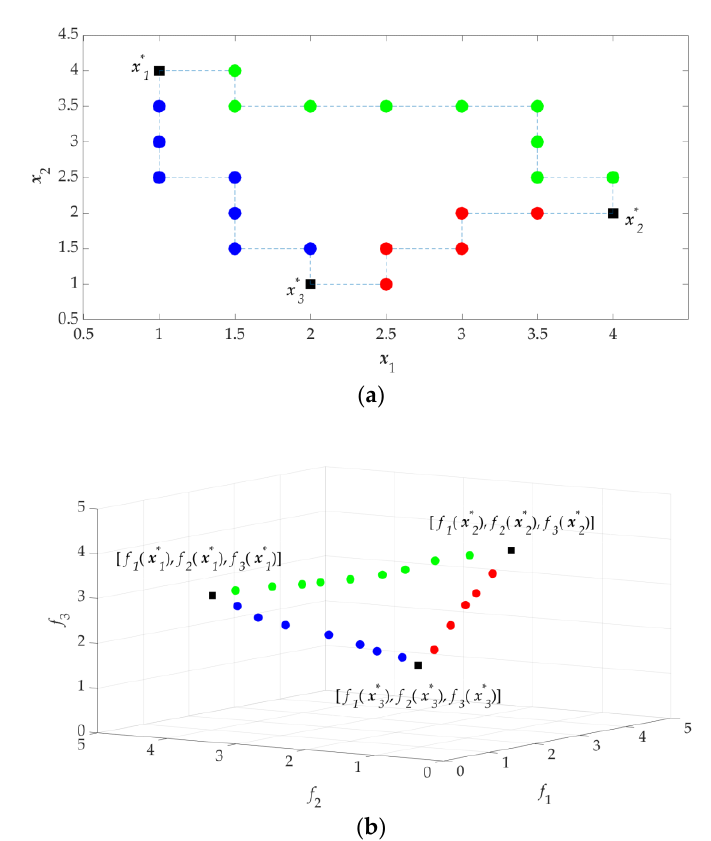
Figure5. Conceptualillustrationofthreedesignobjectives: ( a )designprofile(designspace); ( b )objective Figure 5. Conceptual illustration of three design objectives: ( a ) design profile (design space); ( b ) profile (objective objective profile (objective space).